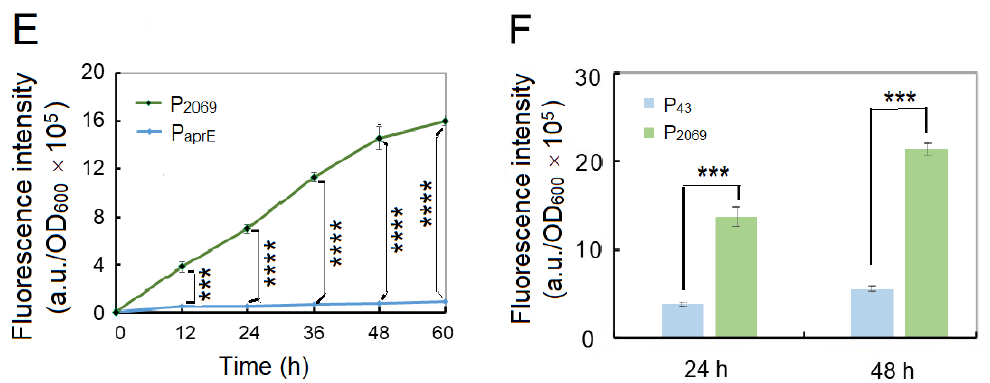
Figure 1. Experimental evaluation of the selected promoters from B. pumilus in B. subtilis . ( A ) Alkaline protease expression under control by di ff erent promoters was assessed by observing size of the hydrolytic circle on the milk-containing agar plates; ( B ) extracellular alkaline protease activity driven by di ff erent promoters at 48 h fermentation; ( C ) comparison of the growth pattern of the B. subtilis recombinants hosting the selected promoters. The bacterial strains were grown in the LB medium at 37 ◦ C with shaking at 200 rpm; ( D ) time course of the extracellular alkaline protease production in various B. subtilis recombinants hosting the selected promoters. The bacterial strains were grown in the LB medium at 37 ◦ C with shaking at 200 rpm; ( E ) fluorescent intensity and cellular growth of two B. subtilis recombinants hosting promoter P 2069 or P aprE ; ( F ) comparison of the promoter strength of P 2069 and P 43 in B. subtilis. The native promoter of the alkaline protease gene was served as the control for Figure 1A–E. Data are averages of three independent experiments with standard deviation. The significant levels were defined with “*” for p < 0.05, “**” for p < 0.01, “***” for p < 0.001 and “****” for p < 0.0001.